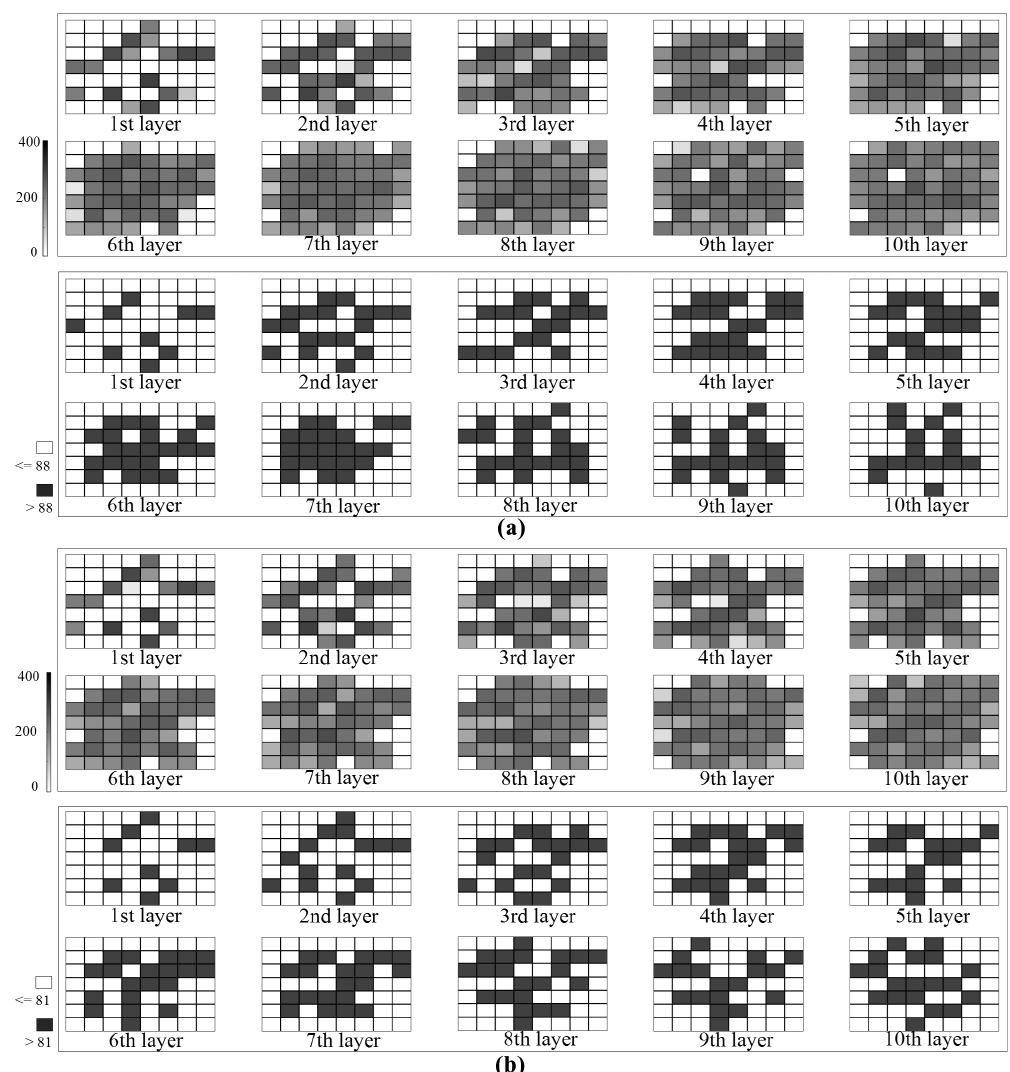
Figure 3. Grayscale graph of number of signal rays passing through each voxel and distribution of voxel with sufficient signal rays ( a, b stand for a rainless and a rainy day,